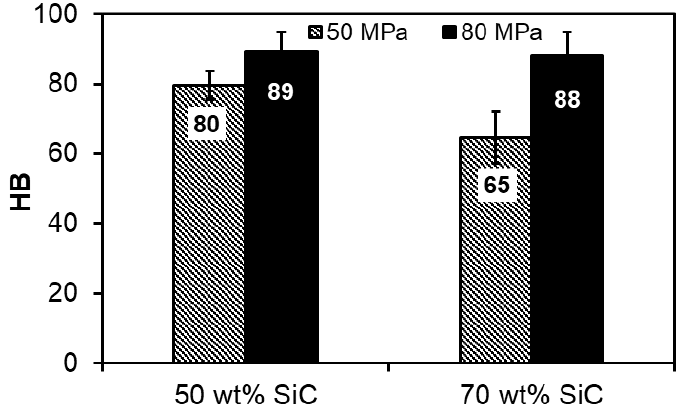
Figure 5. Hardness of spark plasma sintered Al-SiC composites.